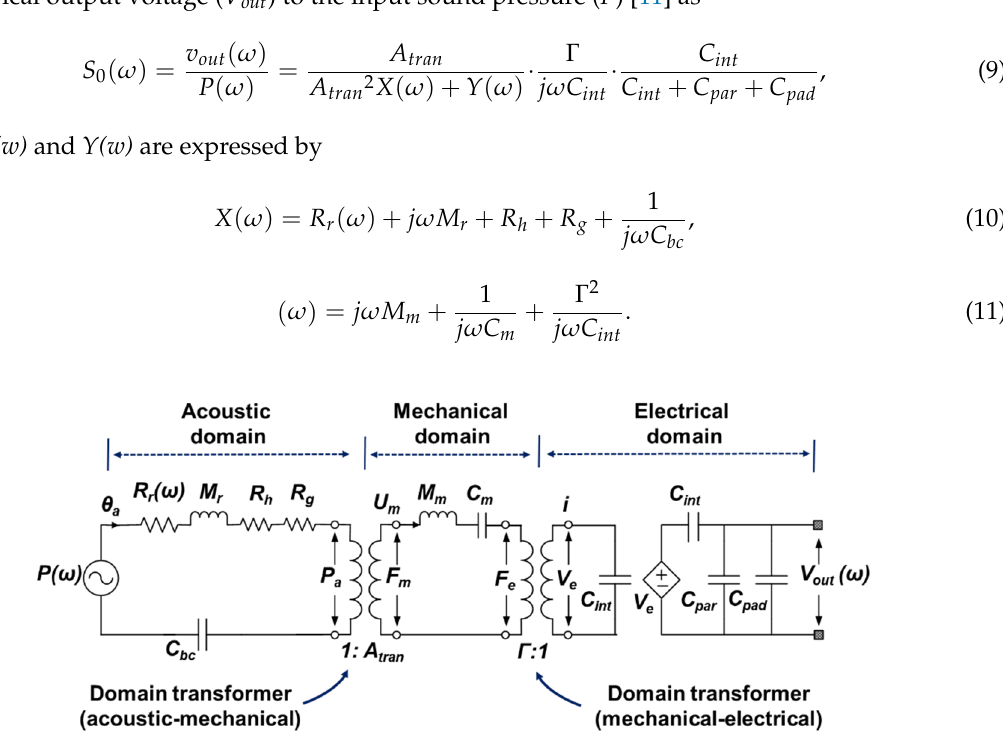
Figure Figure 7. The electrical equivalent circuit consisting of three (acoustic-, mechanical-, and electrical- domain) regions for dynamic open-circuit sensitivity of a capacitive MEMS acoustic sensor.